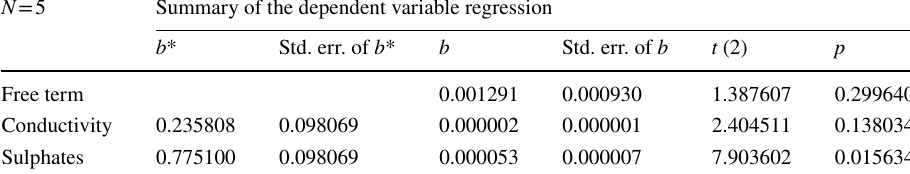
Table 6 Summary of